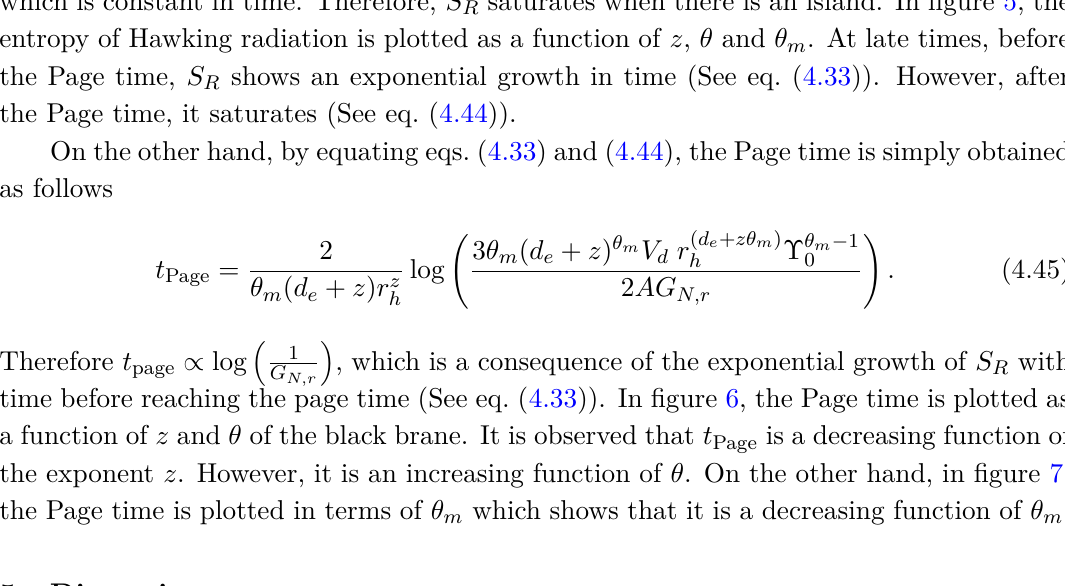
= 1 and different values of θ . ( Right ) θ for d = 2 , θ m 2 = r = 1 and G = 0 . 001 d h N,r